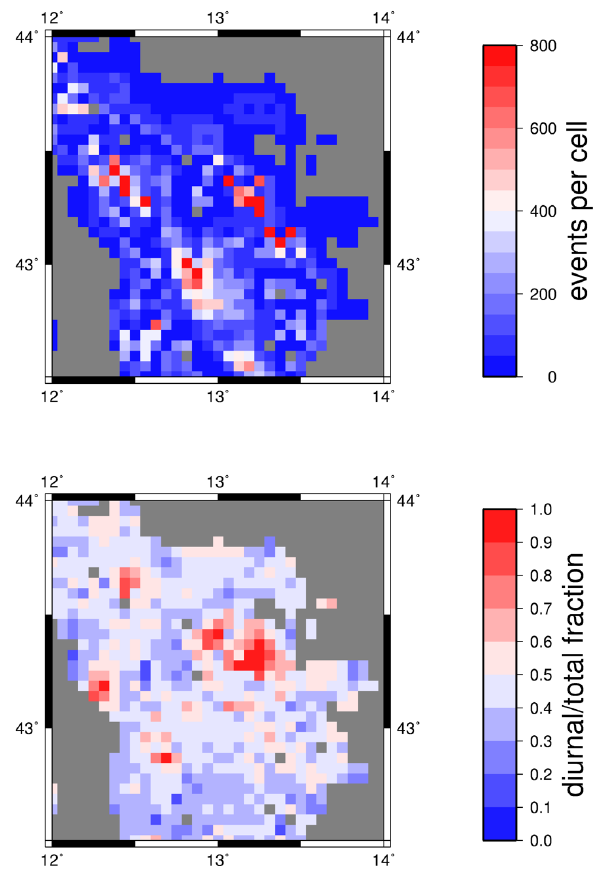
Figure 3. Day/night distribution of events. Top panel: number of events for each cell. Bottom panel: ratio of daytime to total events for each 5 km square cell. Dark blue and dark red colors depict the most anomalous areas.